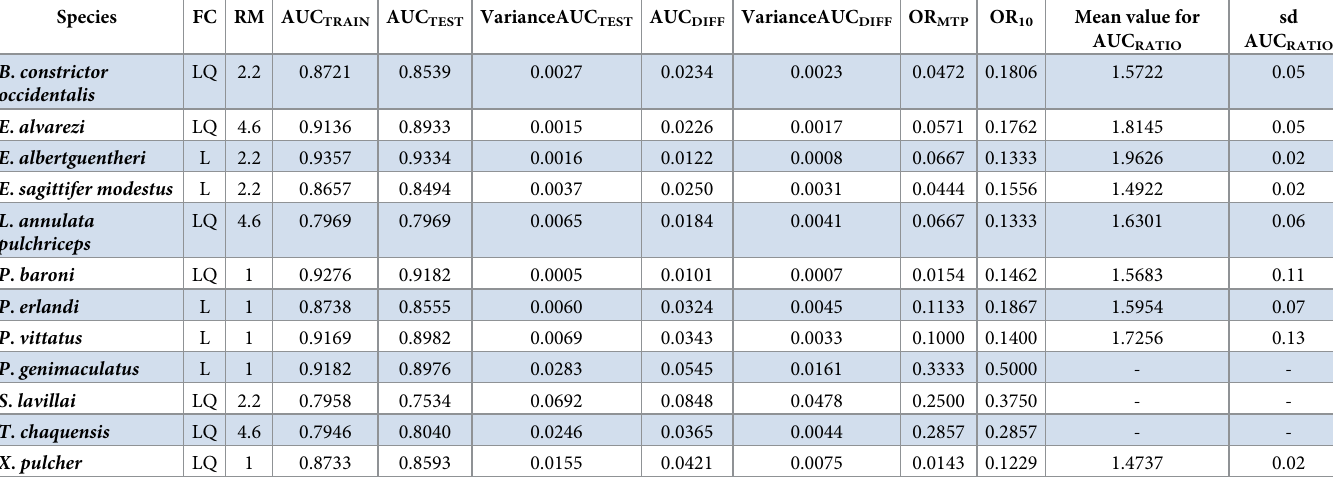
Table 2. Mean AUC TRAIN , AUC TEST , AUC DIFF and Partial ROC (AUC RATIO ) for snake species models with the minimum AICc value. Species